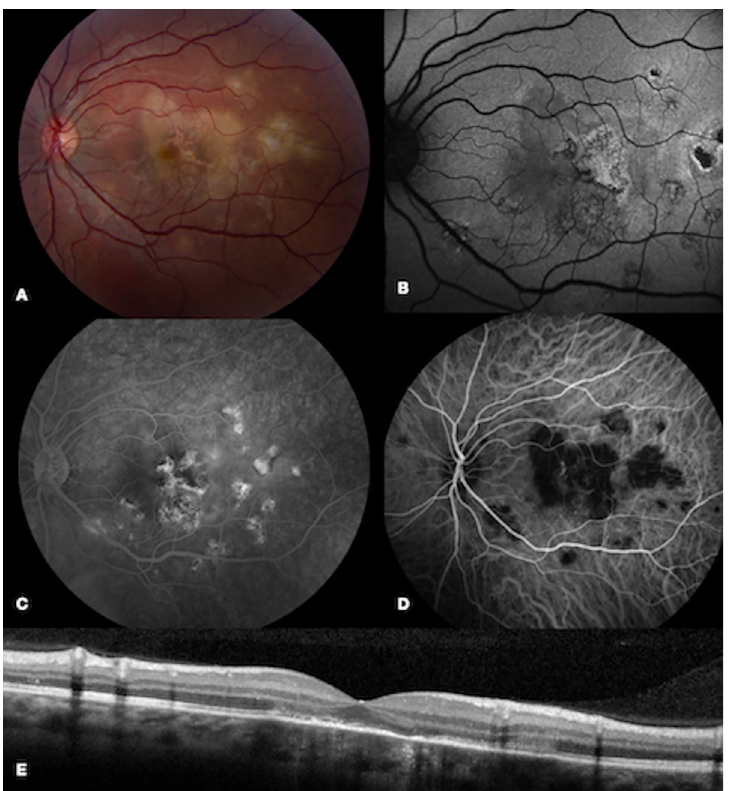
Fig 3. Multimodal imaging during a recurrence of inflammation in patient 5. Fundus photos of the left eye in patient 5 demonstrated multiple new cream-colored lesions near the fovea (A). FAF (B) showed stippled mixed hyperautofluorescent and hypoautofluorescent lesions and FA (C) revealed late hyperfluorescence. ICG (D) demonstrated hypocyanescent lesions that corresponded to the clinically visible lesions. OCT (E) displayed areas of IS-OS disruption.